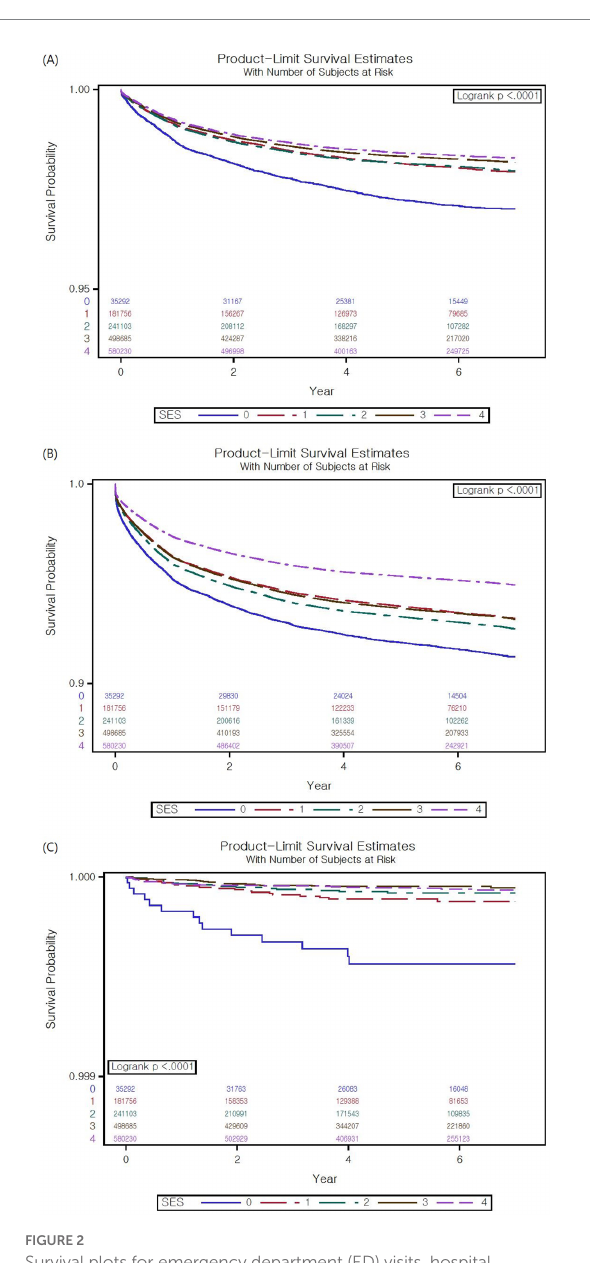
FIGURE 2 Survival plots for emergency department (ED) visits, hospital admission, and intensive care unit (ICU) admission. (A) Survival plot for ED visits. For the visits to ED, the medical aid group (SES 0) had a significantly lower survival probability than the other groups ( p < 0.001). (B) Survival plot for hospital admission. For hospital admission, the medical aid group had the lowest survival probability ( p < 0.001). (C) Survival plot for ICU admission. The medical aid group had a significantly lower survival probability than the other groups in terms of ICU admission ( p <